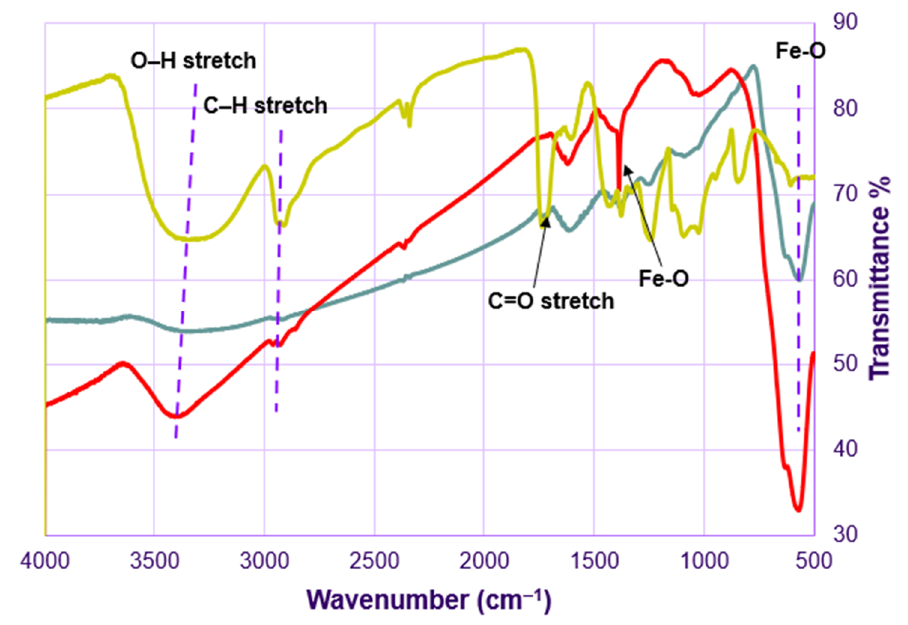
Figure 4. FTIR spectra of Fe 3 O 4 (red), Au (yellow), and Fe 3 O 4 -Au (blue).